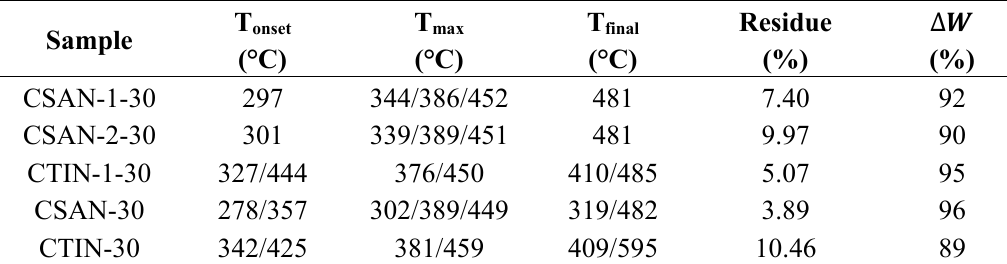
Table 3. Characteristic TGA parameters of the studied oleogel